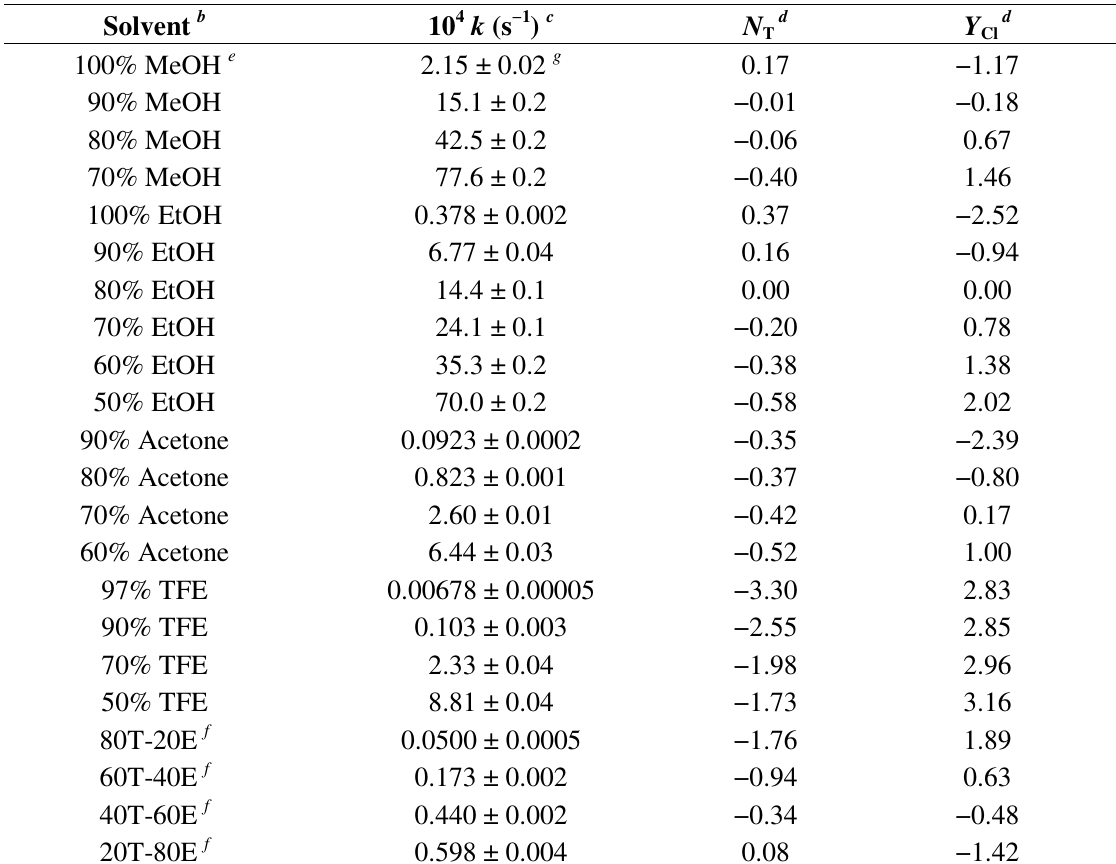
and Y values for the T Cl